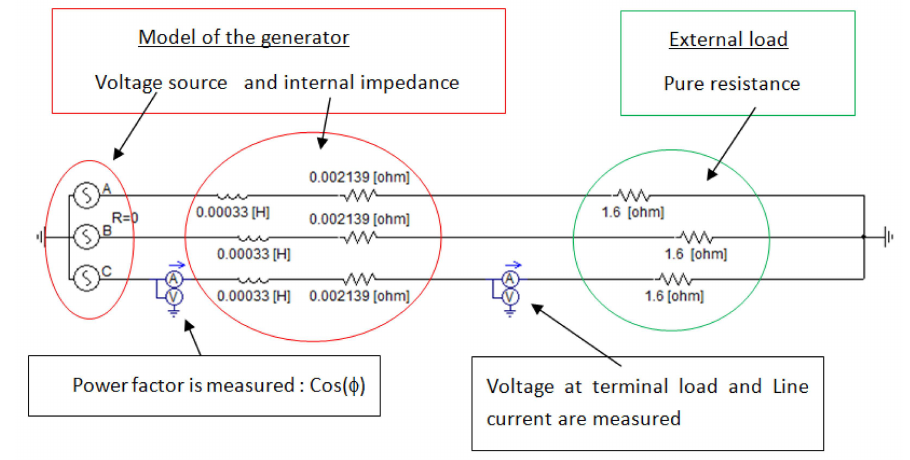
Figure 23. Layout of the simulation which provides data for the calculation of losses in all the part of the machine, in this figure, only one star is presented.